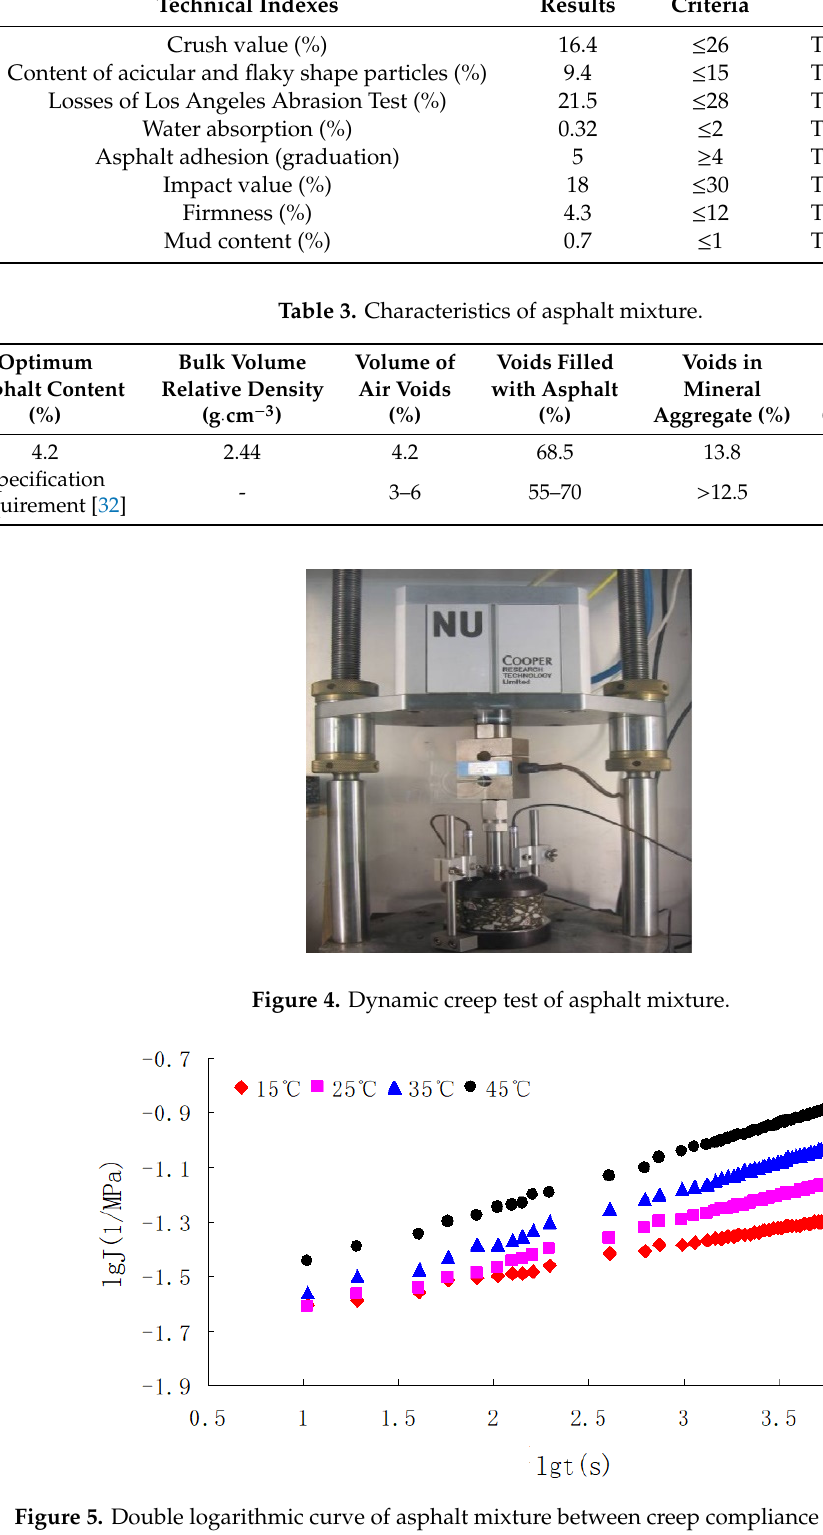
Figure 5. Double logarithmic curve of asphalt mixture between creep compliance and load time.